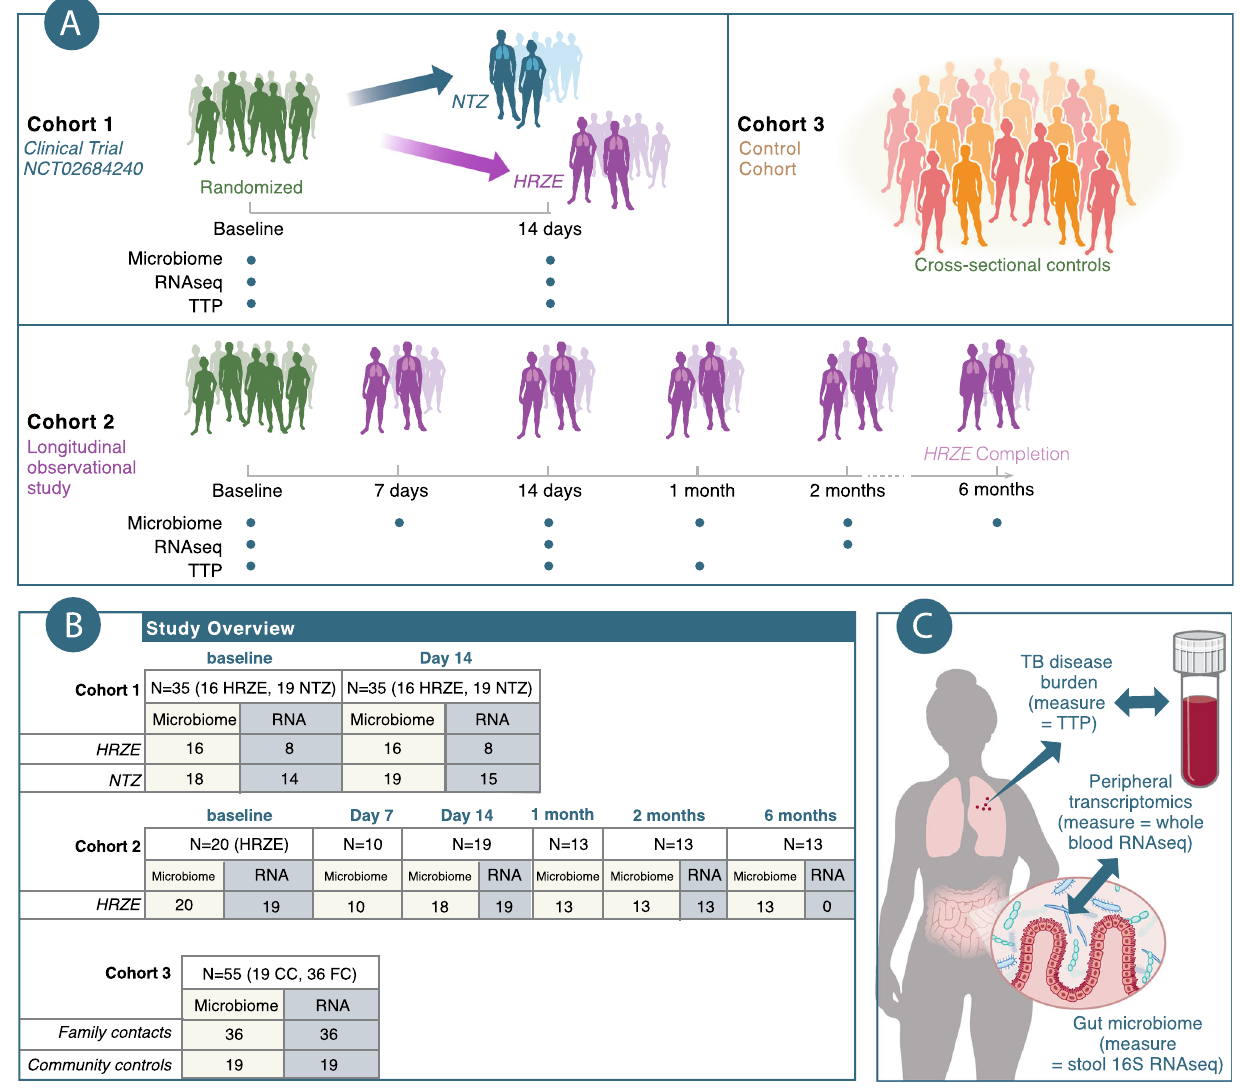
Fig. 1 Overview of cohorts, subjects, timepoints, samples, and hypotheses in this study. A This study investigates microbiome-transcriptome relationships in three separate cohorts of individuals in Haiti. Cohort 1 (2-week longitudinal and interventional clinical trial) consists of secondary analysis of a randomized clinical trial of study volunteers, where we collected disease severity measurements ( Mtb bacterial load, TTP), microbiome pro fi ling, and peripheral transcriptomics in active TB patients at baseline, before randomization to either HRZE (arm 1) (standard of care TB treatment), or Nitazoxanide (NTZ) (arm 2). Cohort 2 (6 month longitudinal and observational study) consists of study volunteers who were followed throughout the course of 6 months of TB treatment, where we collected TTP, microbiome, and transcriptomics data. Finally, Cohort 3 (cross sectional and observational) consists of healthy volunteers. These healthy volunteers were enrolled separately. Around half are healthy and TB-negative household or family contacts (FC) of active TB-patients, and the other half are community controls (CC), with no know TB exposure. We performed microbiome pro fi ling and peripheral transcriptomics on these individuals as well. B Numbers of individuals in this study. C Diagram showing the major questions investigated in this study. Supplementary Data 1 provides a table with dates of fi rst and last enrollment for every